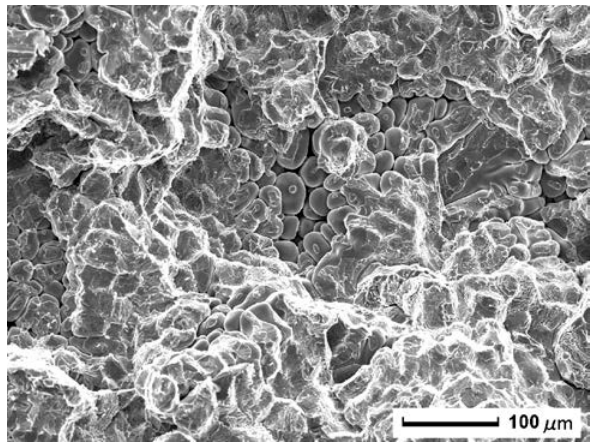
Figure 7. Macroscopic fracture surface of LD10 base metal.